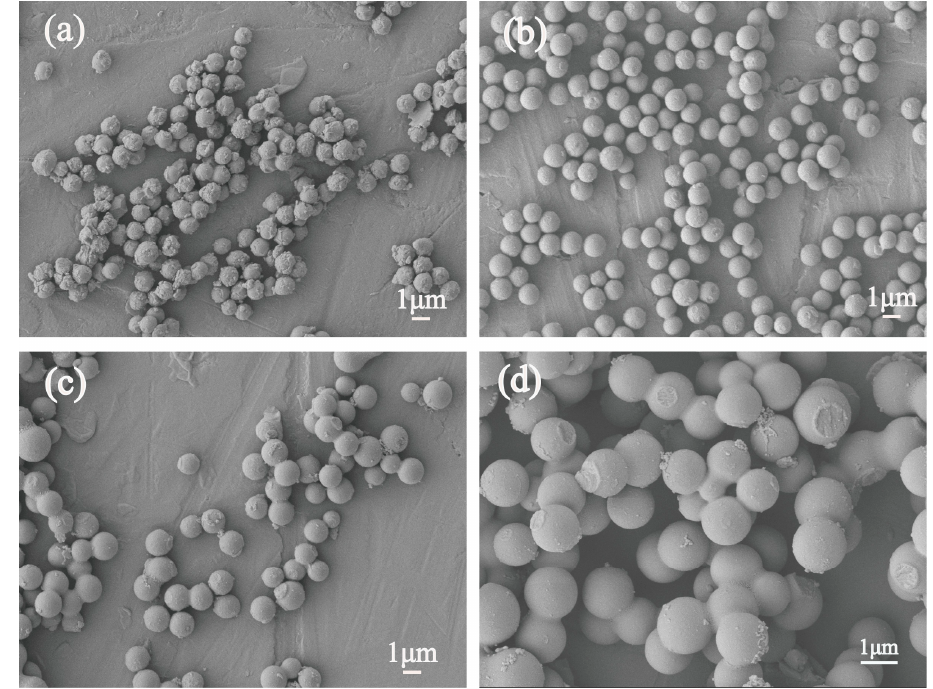
Figure 2. SEM images of Cs with different time periods ( a ) 5 h ( b ) 6 h ( c ) 8 h ( d ) 12 h.